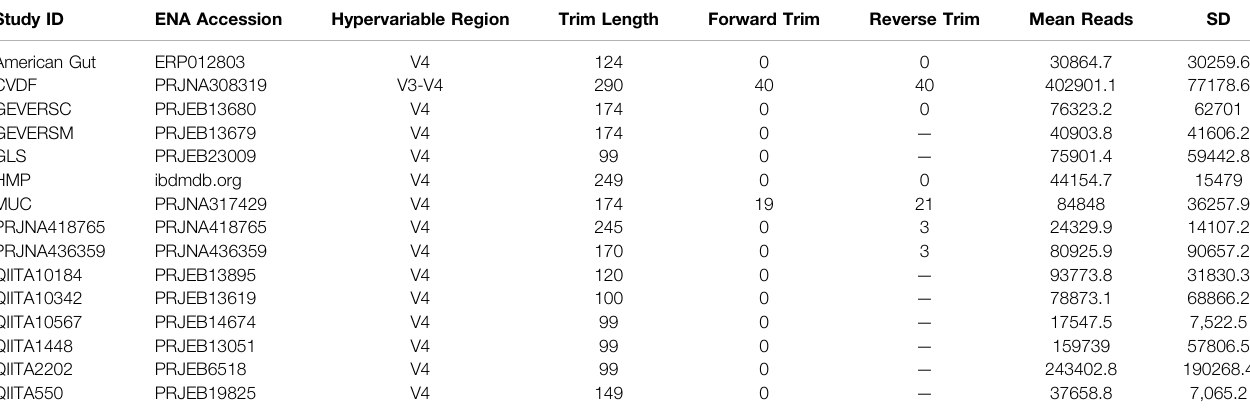
TABLE 1 | Overview of QIIME2 processing for 15 microbiome datasets. Samples were collected from the listed ENA accession, with only samples corresponding to individualsinNorthAmericaretained.SRreferstosinglereadandPEtopaired-endsequencingrunsforthecorrespondinglengthinbp.Trimlengthwasusedasinputfor the trunc_len parameter, forward trim as the trim_left input for single end read and trim_left_f for paired-end reads, and reverse trim as the trim_left_r input for paired-end reads in the python API for QIIME2 ’ s Dada2